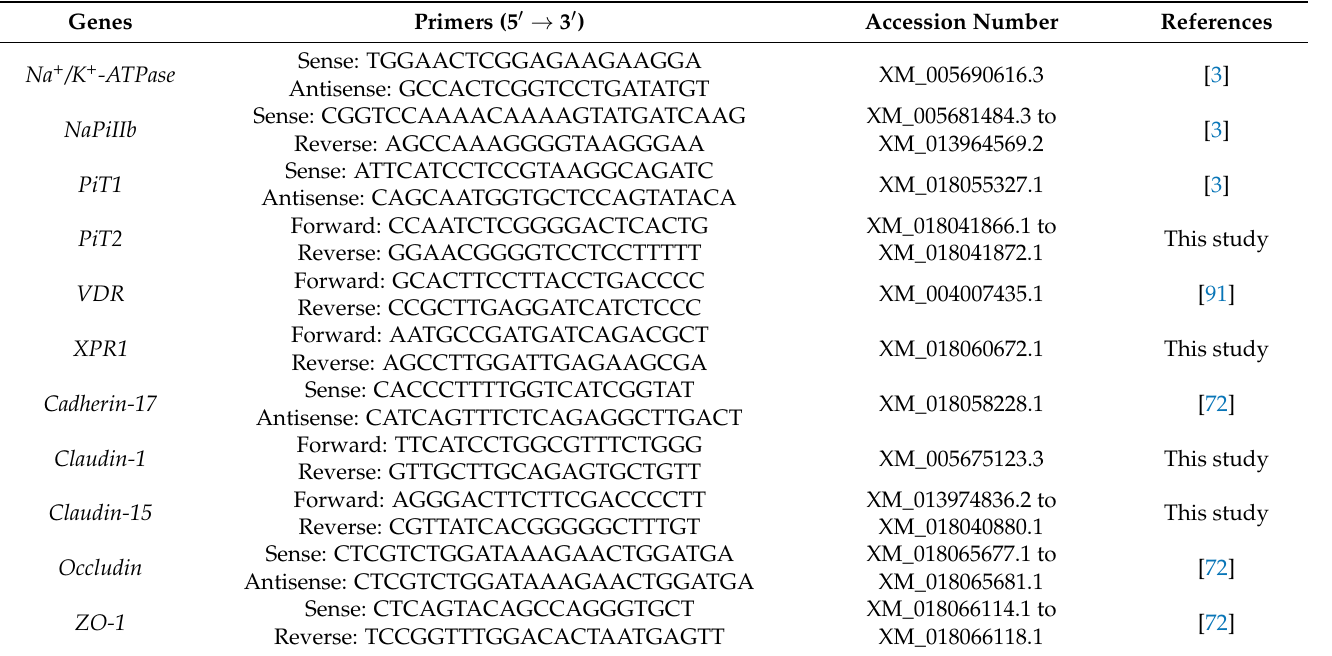
Table 11. Primers used for SYBR Green